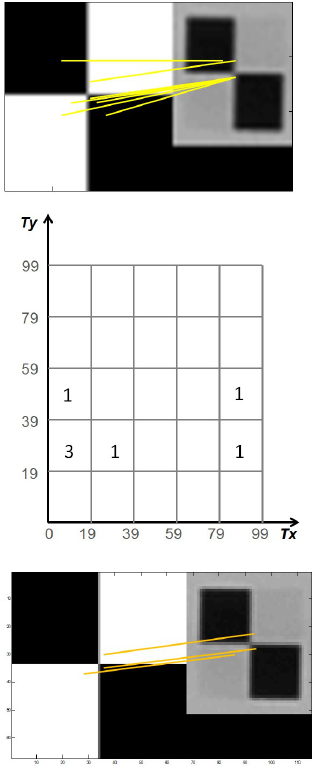
Figure 4. UAV with the FPI camera on board.